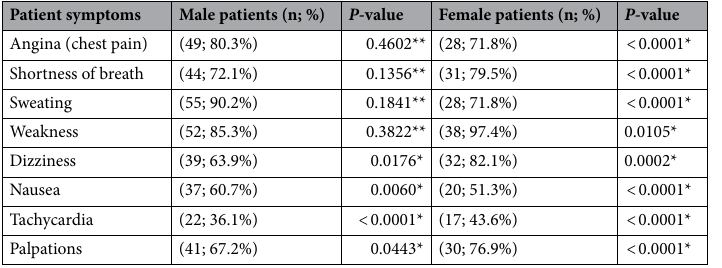
Table 4. Symptoms presentation (n; %) in IHD patients. *Significant correlation ( p ≤ 0.05). **No significant correlation ( p > 0.05).